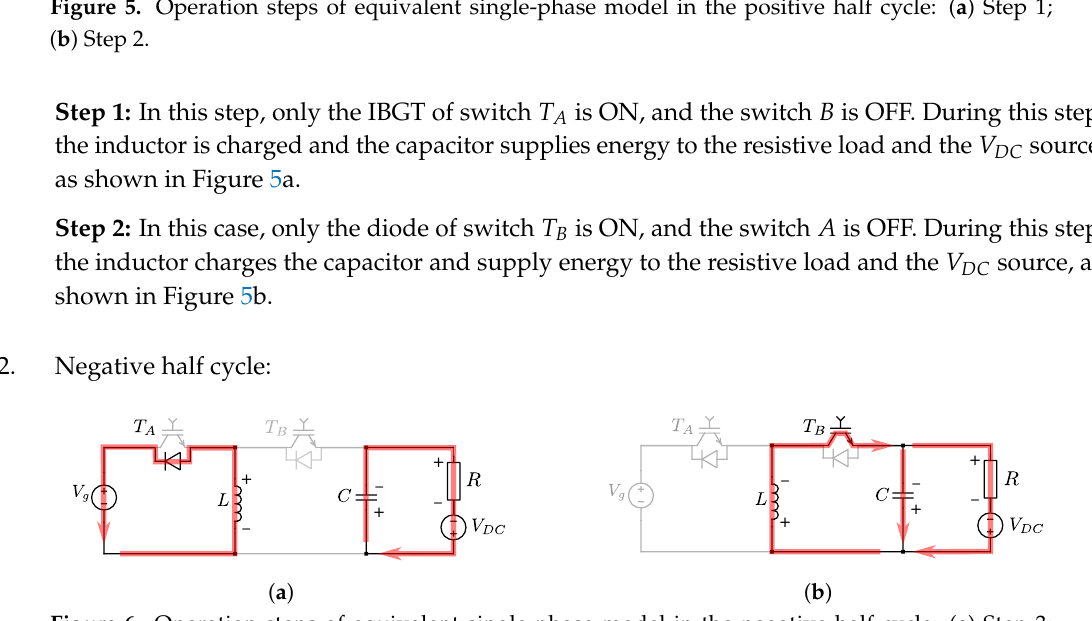
Figure 6. Operation steps of equivalent single-phase model in the negative half cycle: ( a ) Step 3; ( b ) Step